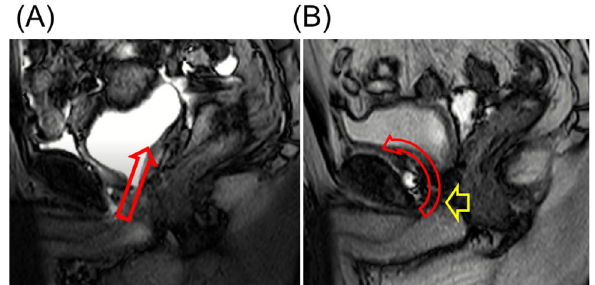
Figure 6. ( A ) Magnetic resonance imaging (MRI) after conventional robot-assisted radical prostatectomy (C-RARP). In C-RARP, the urethrovesical anastomosis is thought to be pulled cephalodorsally (red arrow) because the bladder vasculature is fixed from both dorsolateral sides. ( B ) MRI after Retzius-sparing RARP (RS-RARP). In RS-RARP, the anterior bladder wall is widely fixed, and the urethrovesical anastomosis is thought to be pulled cephalad ventrally (red arrow). After RS-RARP, the urethra is pushed in the direction of the pubic bone (yellow arrow), and the urethral closure pressure at rest may be higher than that after conventional